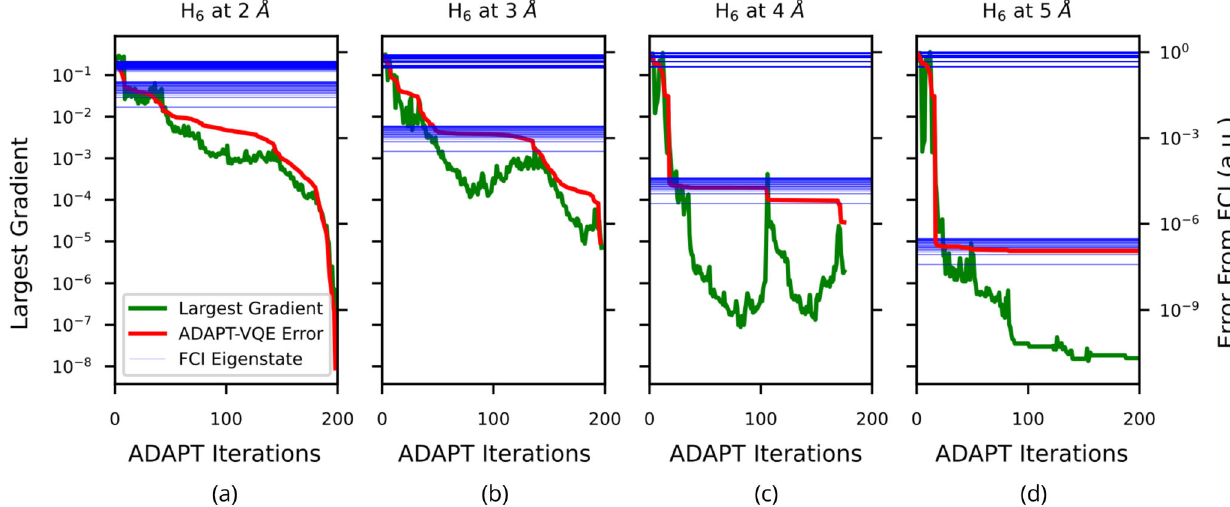
Fig. 8 Gradient troughs at eigenstates. Overlay of the ADAPT-VQE error vs. iteration (red line, right axis) with the FCI excited states (blue horizontal lines, right axis) for H 6 . Plots a , b , c , and d correspond to bond lengths 2, 3, 4, and 5 Å respectively. The x -axis corresponds to the ADAPT-VQE iteration. The largest pool gradient associated with the operator to be added at each step is shown in green (left axis).